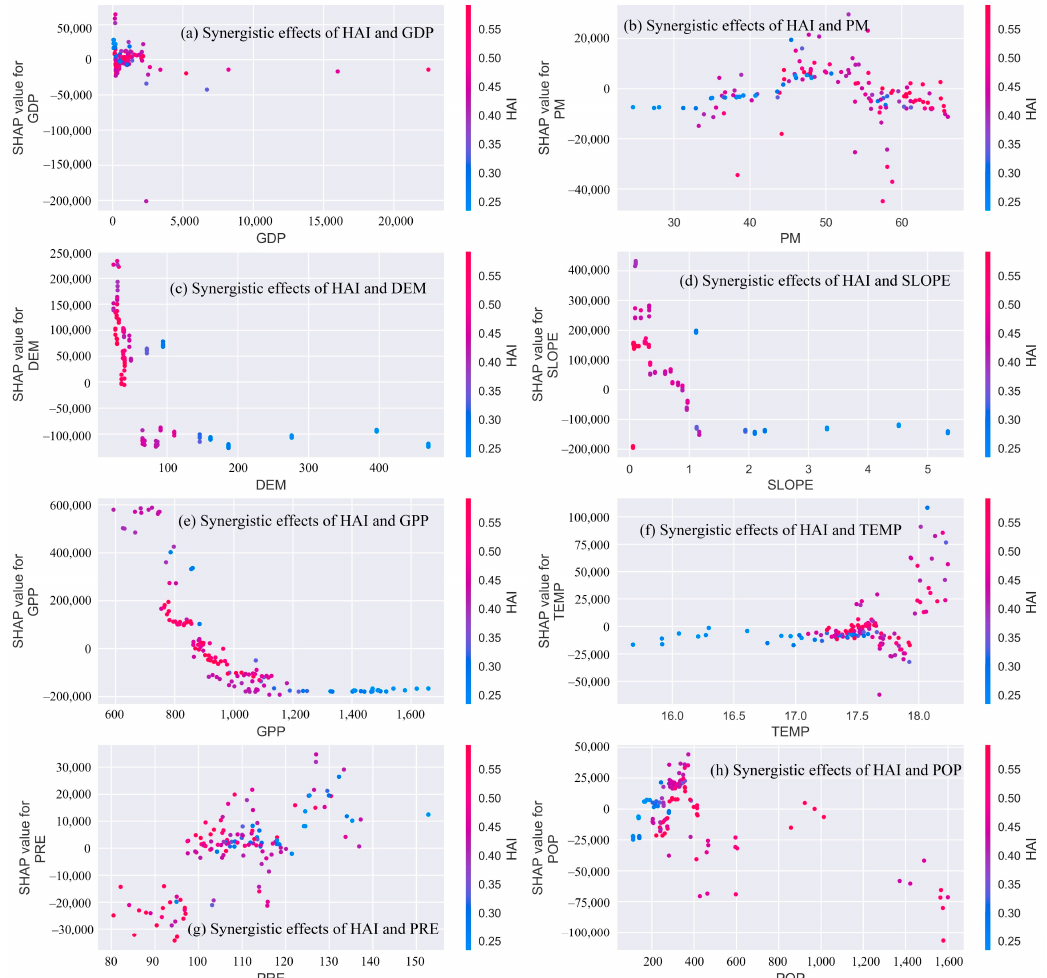
Figure 7. Shape dependence plot of the importance of driving factors in the Dongting Lake in 2000, 2005, 2010 and 2018. The x -axis represents the driving factor values, and the y -axis represents the SHAP values. The red to blue bars on the right sides of the graphs indicate high to low values of the HAI,